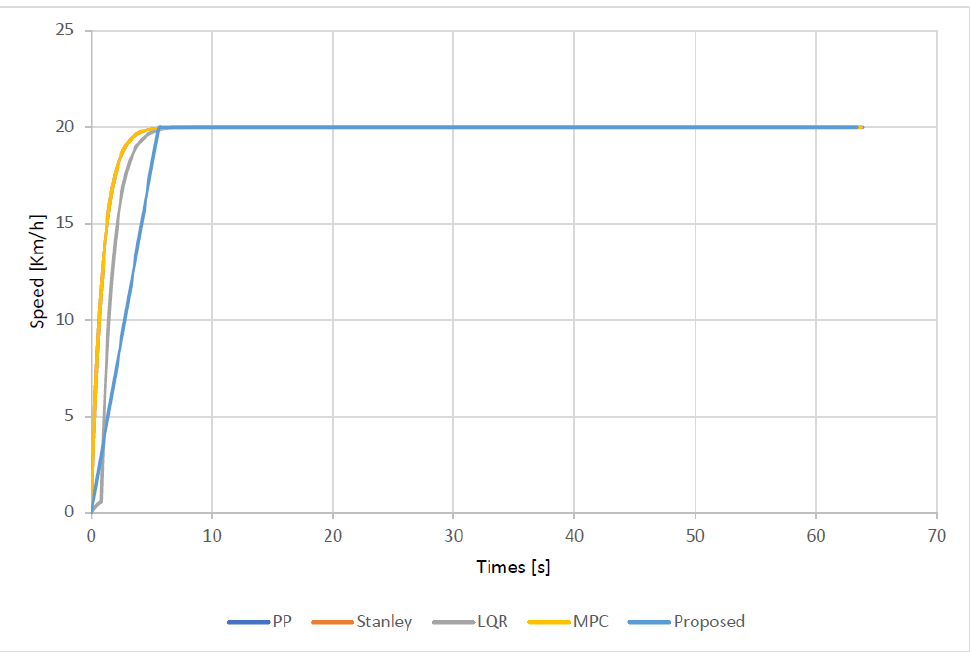
Figure 7. Speed comparison of different trajectory tracking controllers in the simulated